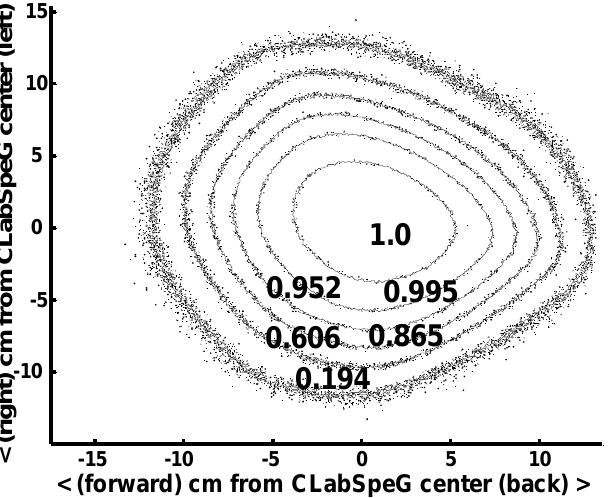
Figure 3. Changing radiance intensity of light source footprint. Light was at 15° zenith and 90° azimuth. Radiance was measured over the Spectralon at 600 nm. The six grid values correspond to the viewing area for various sensor zenith angle positions while in 0° azimuth. Maximum intensity occurs at nadir position of the sensor, while minimum intensity value corresponds to 75°. In between values corresponds to 15° increment. Values were normalized to nadir intensity and presented on the